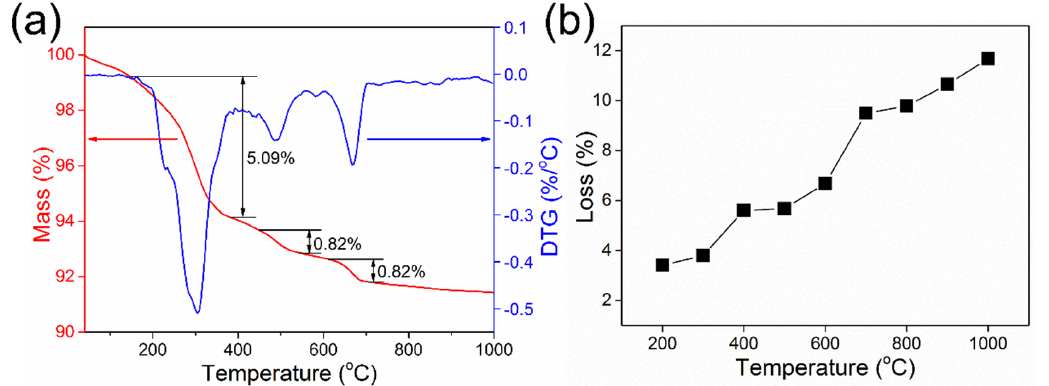
Figure 4. ( a ) TG-DTG curves of the red mud sample, ( b ) mass loss of calcined samples with different calcination temperatures.